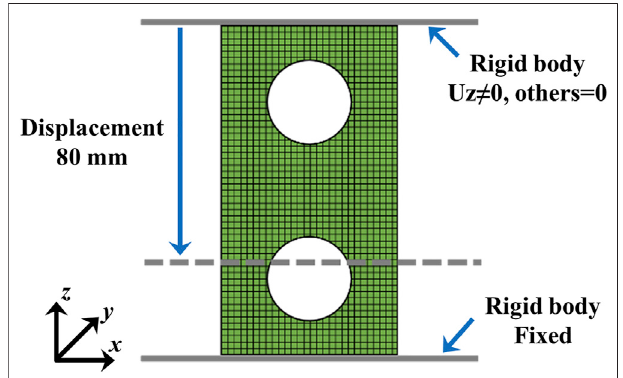
FIGURE 9 | Sketch of simulation